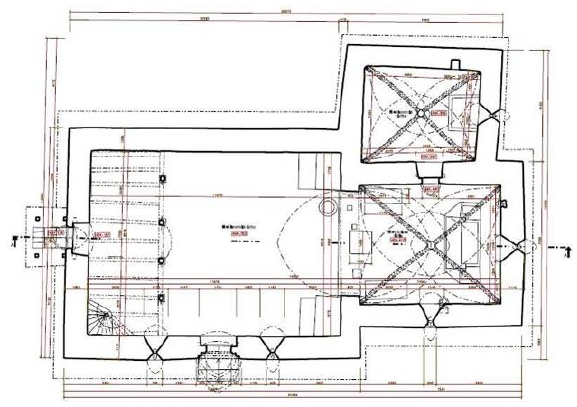
Figure 7. Ground plan section of the church in Čerín